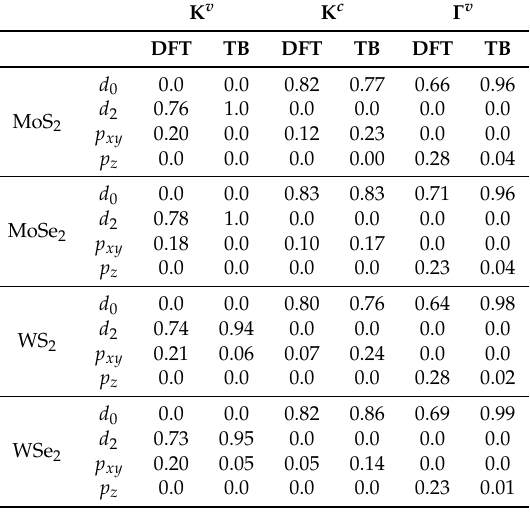
Table 3. Comparison of the orbital contribution at band edges at K and Γ points obtained from DFT (Density Functional Theory) and TB (tight-binding) models. K v (K c ) refers to the edge of the valence (conduction) band at K point, and Γ v refers to the edge of the valence band at the Γ point. K v K